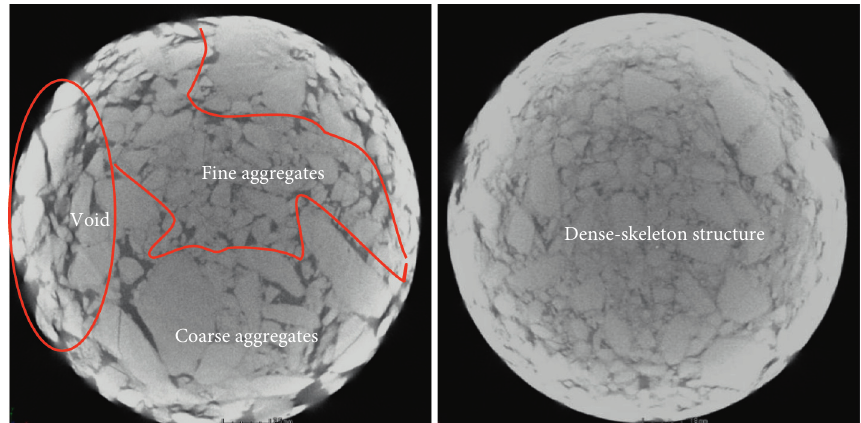
Figure 15: The X-ray CT test results of the circular cross section of cement-treated aggregates prepared by different mixing